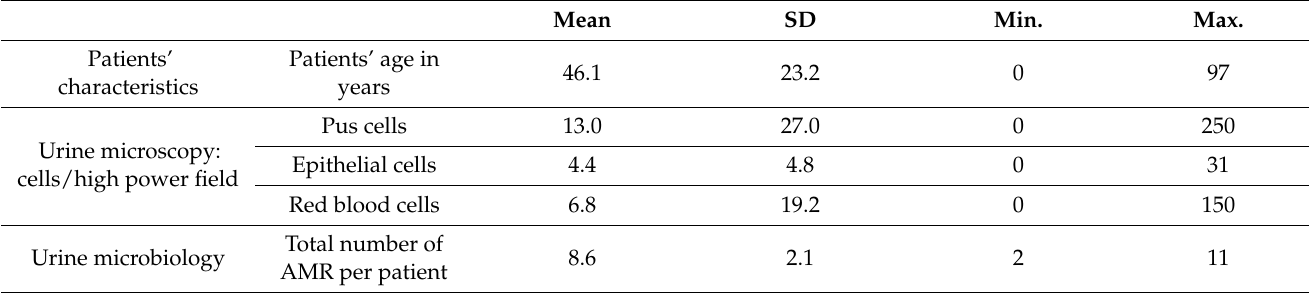
Table 2. Summary of patient characteristics and results of standard testing (n = 110). Mean SD Min. Max.